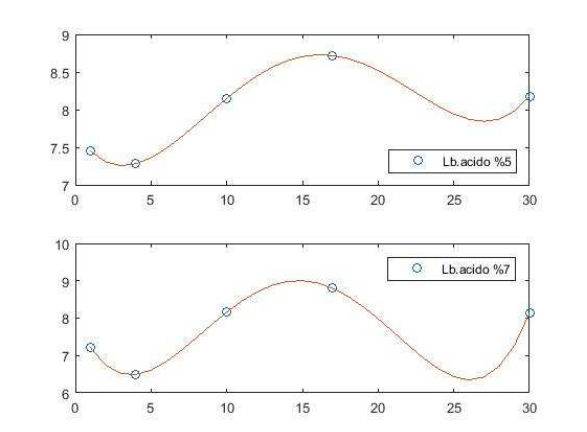
Figure 8. The graphics of the mem- bership functions for Lb. acidophilus number (the x-axis represent the days and the y-axis represent the Lb. aci- dophilus